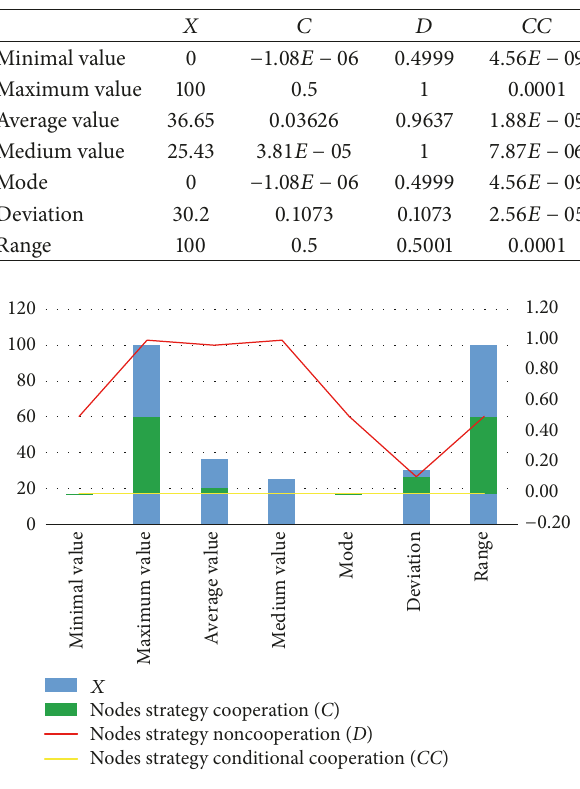
Figure 3: The state of population when 𝑋 = (0, 100, 36.64, 25.43, 0, 30.19, 100).